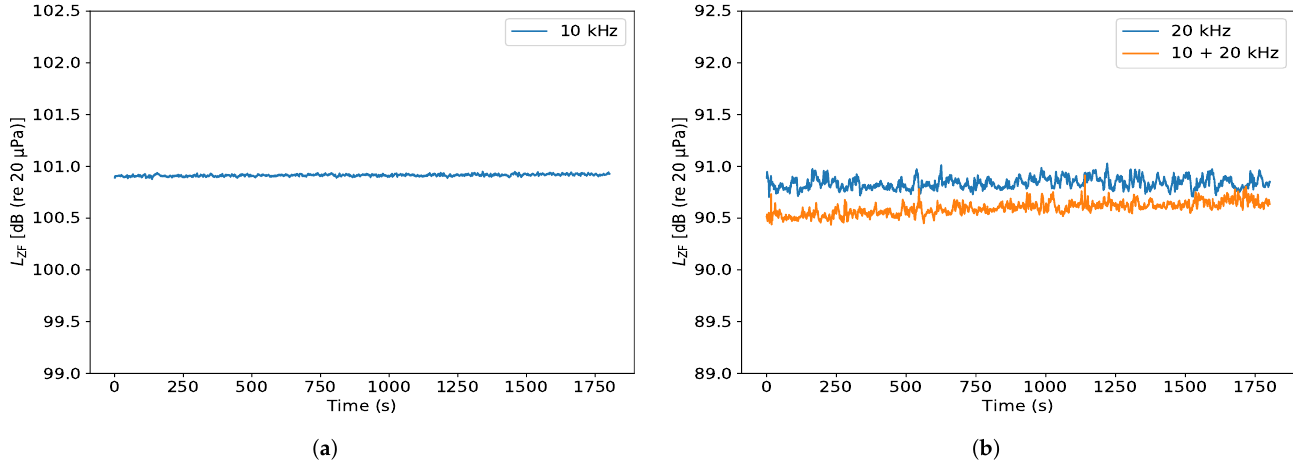
Figure 7. Sound pressure level recorded over the period of 30 min, at the distance of 10 cm away from the loudspeaker, for the following signals ( a ) 10 kHz sine wave and ( b ) 20 kHz sine wave and 10 kHz + 20 kHz multi-sine